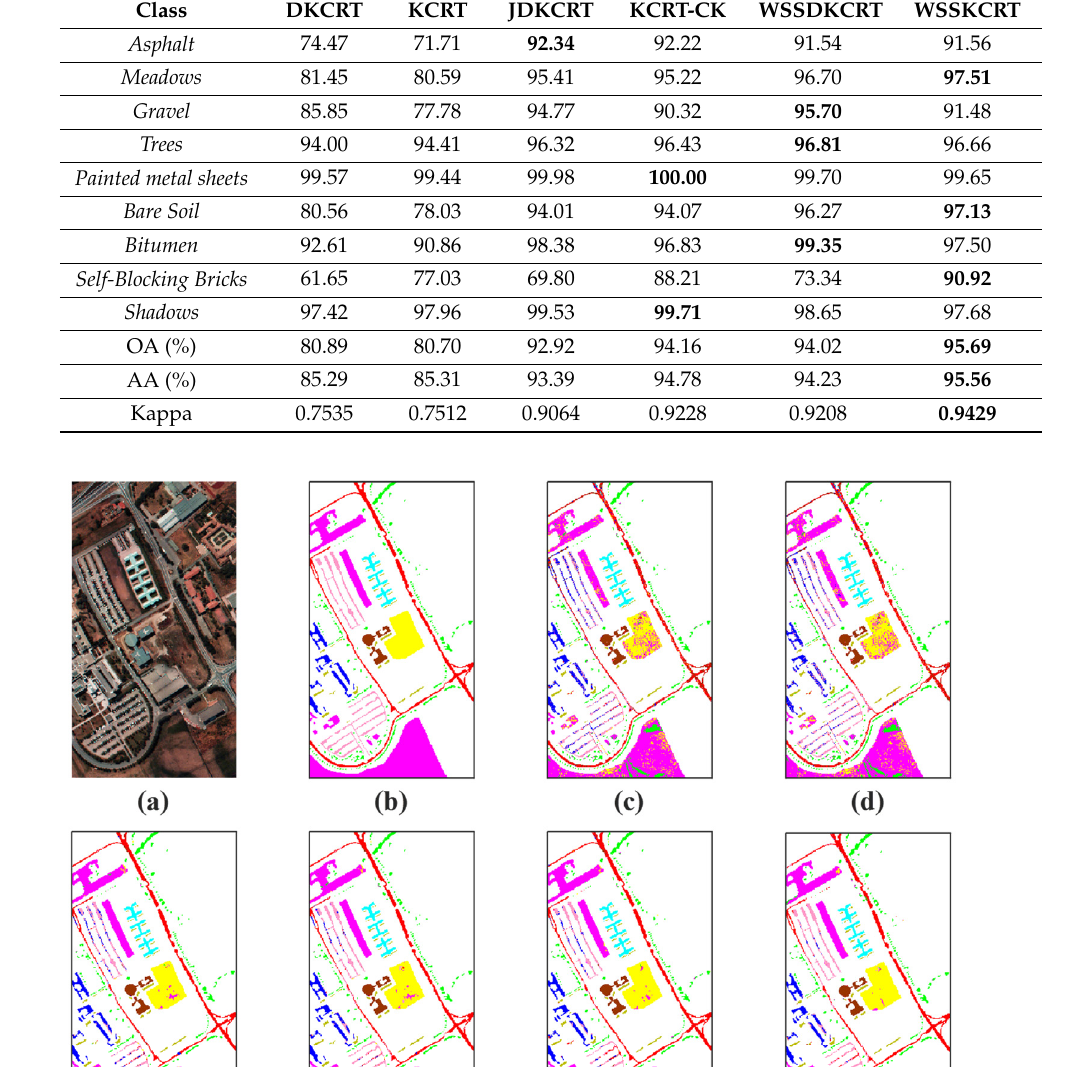
Table 3. Classification accuracy for land cover types.